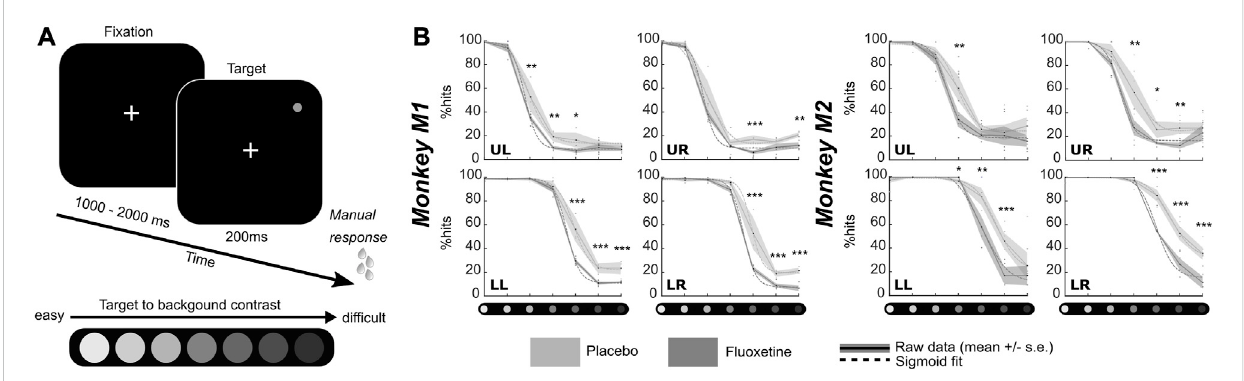
FIGURE 1 Effect of fl uoxetine on perceptual thresholds in a luminance detection task. (A) Monkeys had to detect a target presented in one of four quadrants. Target luminosity ranged from high to low luminosity in 7 steps. Monkeys were rewarded for a speeded detection of target presentation. Targets were presented at four different locations, in the upper left (UL), upper right (UR), lower right (LR) and lower left (LL) quadrants, at 8 ° of eccentricity from the centerofthescreen,for200 ms. (B) Forbothmonkeys,%ofhitswerecomputedindependentlyforeachtargetluminosity.Dotsrepresentindividual sessions, continuous lines represent average % hits across all sessions (+/-median absolute error) and dashed lines represent sigmoid fi t of the data. Placebodataarerepresentedinlightgrayand fl uoxetinedataarerepresentedindarkgray.Behavioraldataarerepresentedindependentlyforeachtarget position. Statistical signi fi cance is represented as follows: ***, p < 0.001; **, p < 0.01; *, p < 0.05; n. s., p > 0.05. See also companionSupplementary Table S2 for detailed